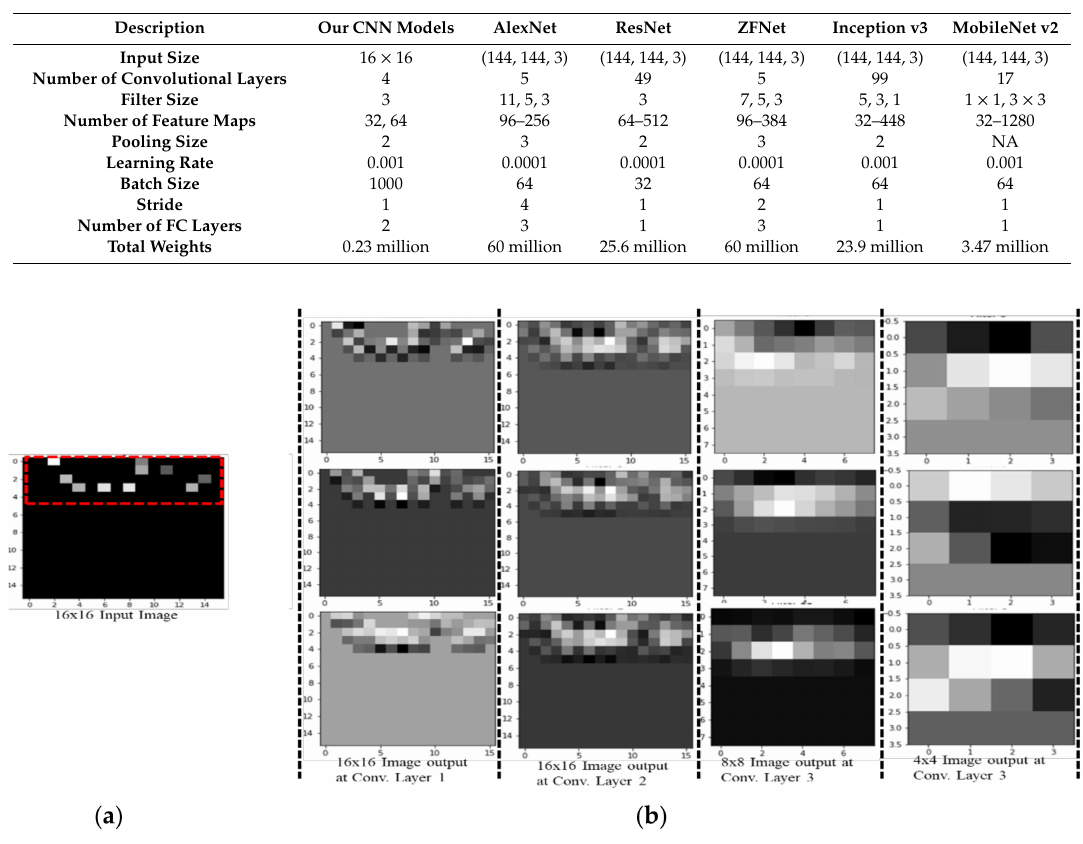
Figure 3. Images for our CNN model. ( a ) Input image. ( b ) Output image with different convolutional